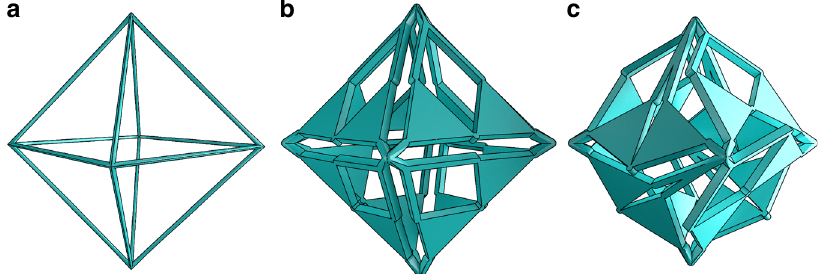
Fig. 7 Dilation of an octahedron. Eight pantograph linkages are placed on the octahedron. a shows the wireframe of an octahedron. b shows the dilational structure in the neutral position, ( θ ¼ 0) and ( c ) shows a compacted position ( θ ¼ 25 (cid:4) )